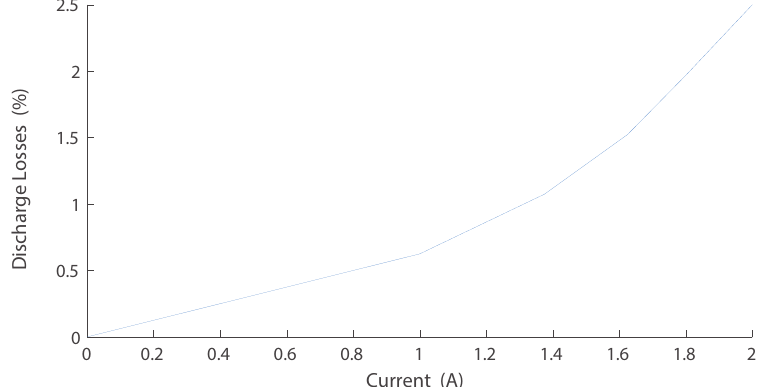
Figure 13. Battery management system prototype discharge